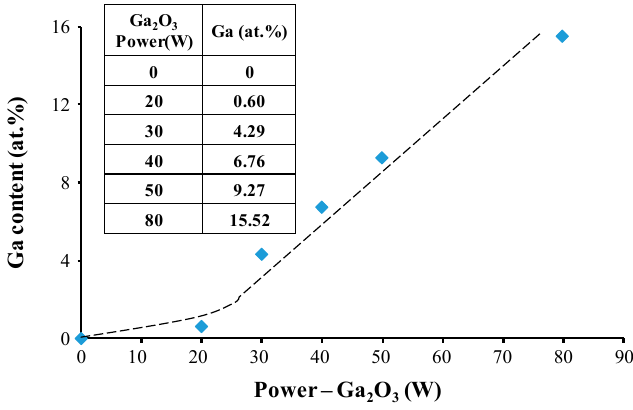
Figure 1. Ga content in ZnO thin films as a function of the sputtering power applied on the Ga 2 O 3 target.